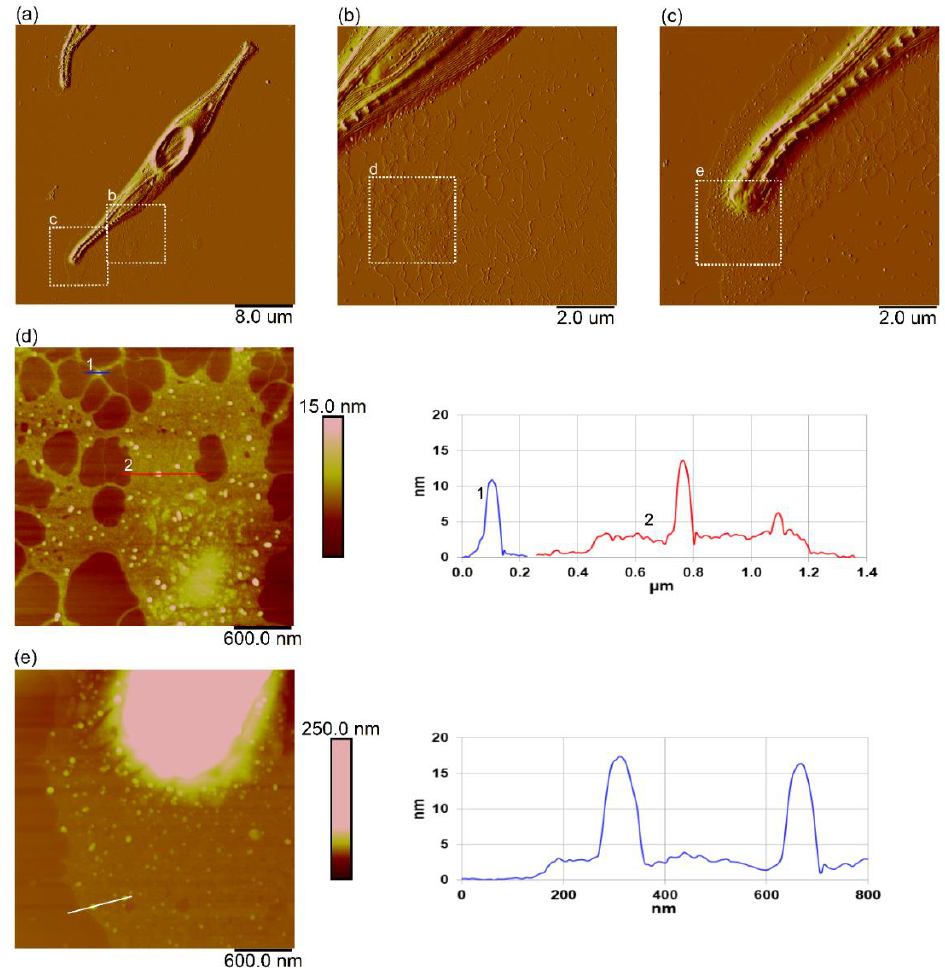
Figure 5. AFM images of Cylindrotheca closterium cells spiked with SiO 2 (10 µ g mL − 1 ) nanoparticles showing C. closterium cell and released EPS with embedded SiO 2 nanoparticles. Images were acquired using contact mode in air and presented as amplitude data ( a – c ) and height ( d , e ). Scan sizes 40 µ m × 40 µ m ( a ); 10 µ m × 10 µ m ( b , c ); 3 µ m × 3 µ m ( d , e ) with vertical profiles along indicated lines showing the height of EPS and embedded nanoparticles. Line crossing EPS and nanoparticles and belonging vertical profile along indicated line in (d) are shown in the same color and indicated by the same